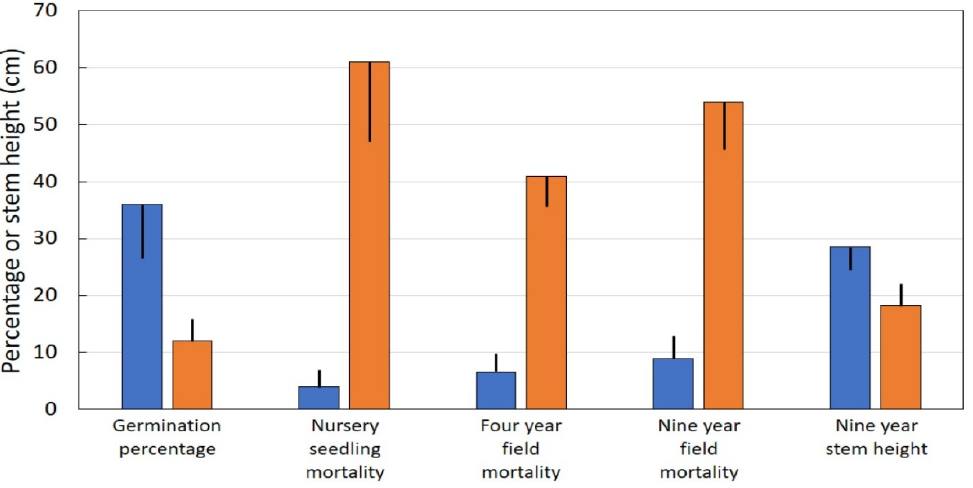
Figure 3. Performance of Cycas micronesica seeds with or without substantial Aulacaspis yasumatsui infestations. Blue bars = minimal scale infestation, orange bars = considerable scale infestation. Mean plus or minus SE.